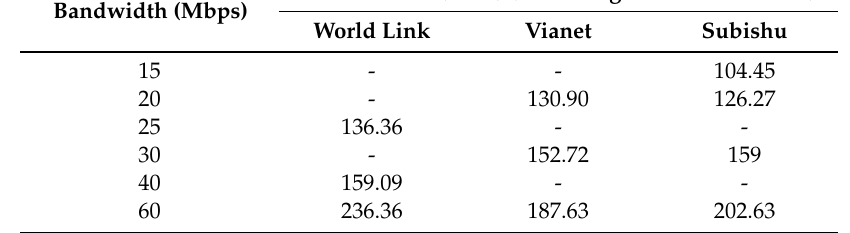
Table 2. Mobile broadband prices in South Asian countries [11].